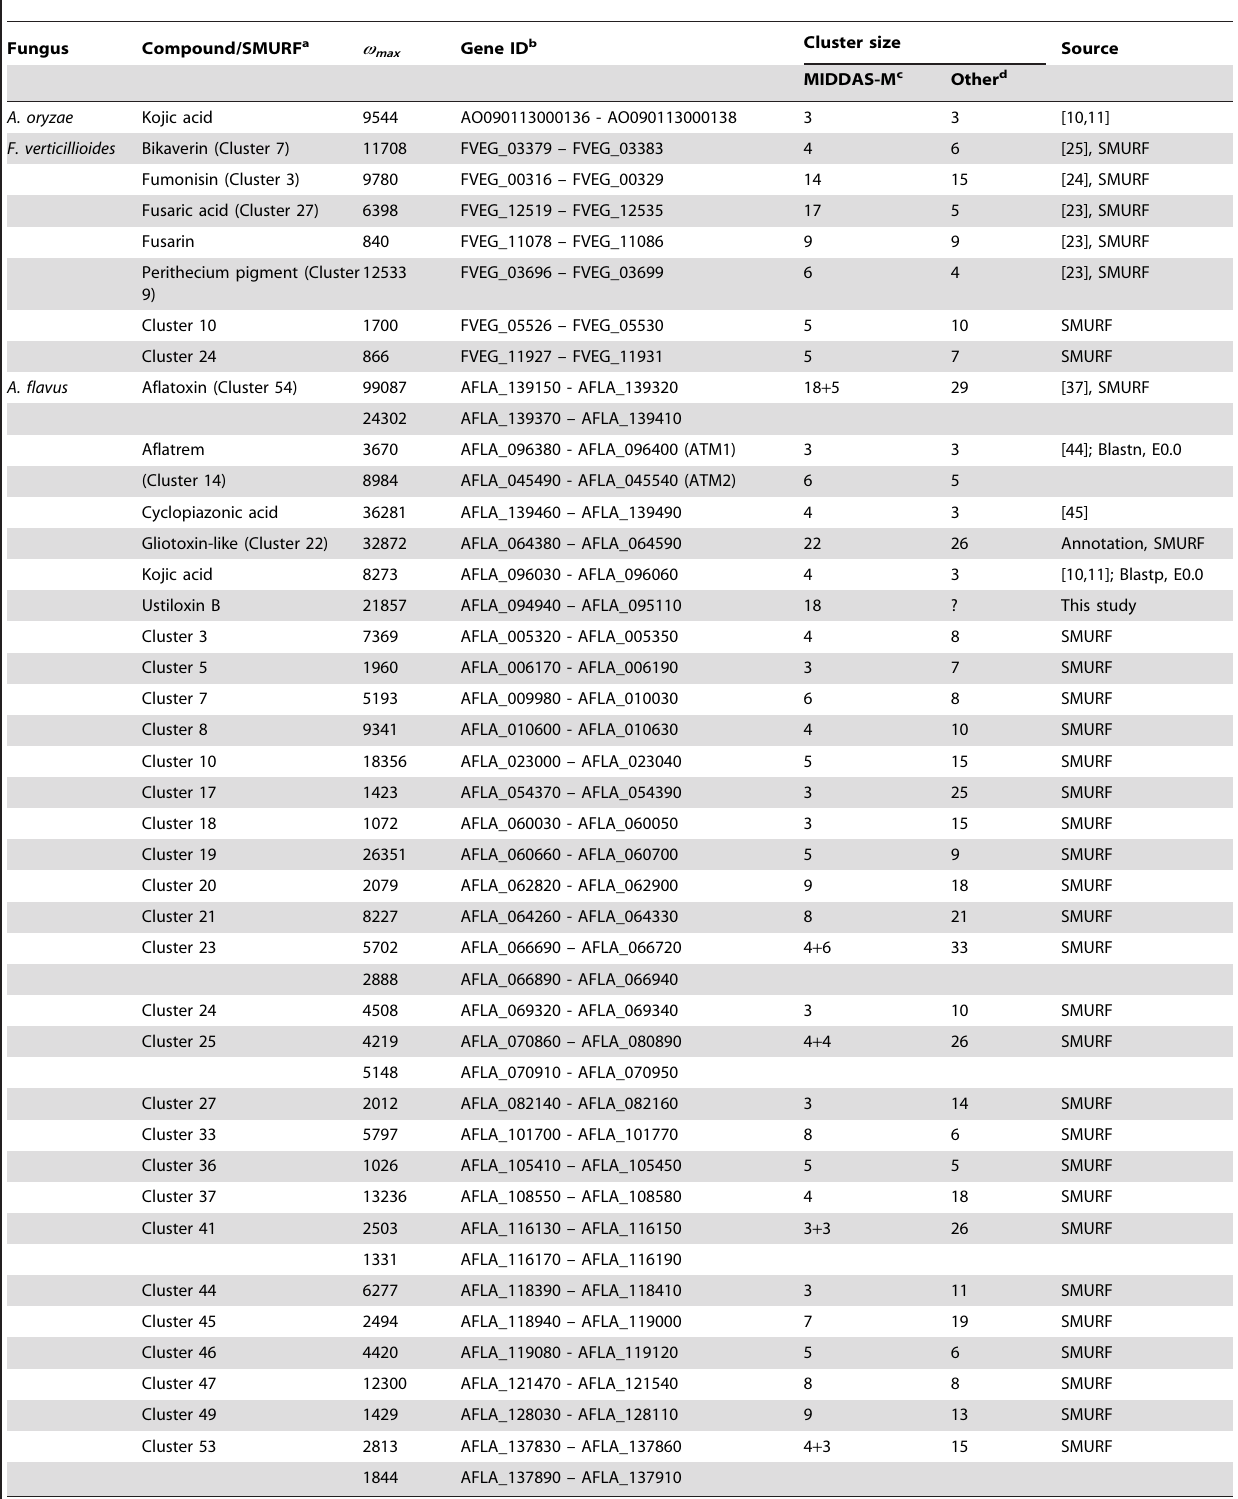
Table 1. Experimentally-validated or SMURF-annotated SMB gene clusters detected by MIDDAS-M.